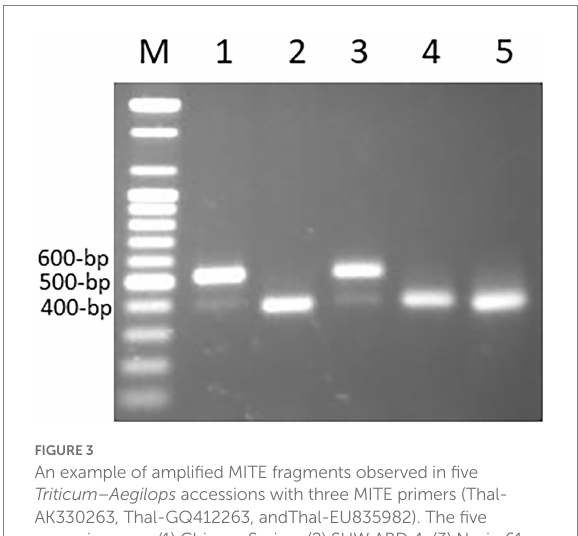
FIGURE 3 An example of amplified MITE fragments observed in five Triticum–Aegilops accessions with three MITE primers (Thal- AK330263, Thal-GQ412263, andThal-EU835982). The five accessions are: (1) Chinese Spring; (2) SHW ABD 4; (3) Norin 61; (4) T. turgidum ; (5) Ae.